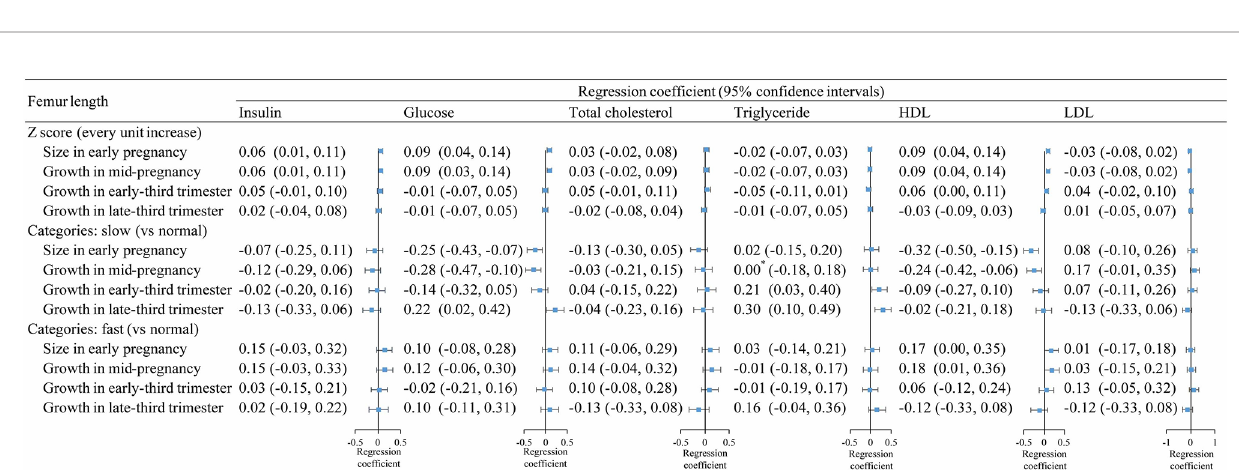
FIGURE 2 | Association between fetal abdominal circumference growth in different periods and cord blood metabolic factors. *, >0 and <0.001.